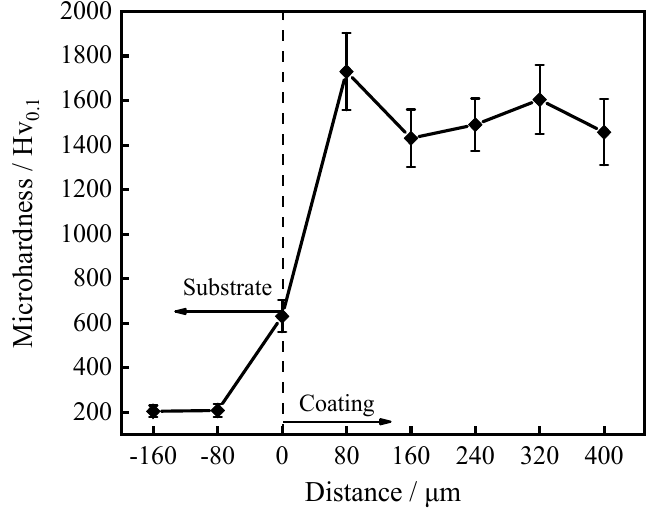
Figure 7. Cross-section hardness distribution curve.